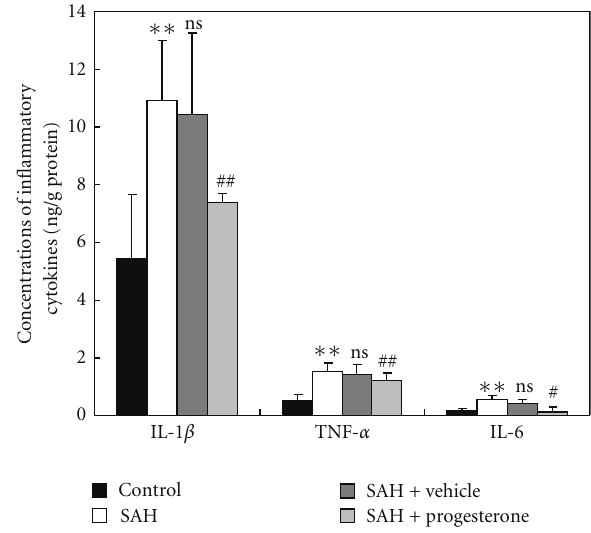
Figure 4: Changes of inflammatory mediators in the injured brains as determined by ELISA in control group ( n = 6), SAH group ( n = 6), SAH + vehicle group ( n = 6), and SAH + progesterone group ( n = 6). SAH could induce the significantly increased concentrations of IL-1 β , TNF- α and IL-6 in the rat brain surrounding the blood clot. In SAH + progesterone group, the cortical concentrations of IL-1 β , TNF- α and IL-6 were markedly down-regulated as compared with that of SAH + vehicle group. Bars represent the mean ± SD ( n = 6, each group). ∗∗ P < . 01 compared with control group, # P < . 05 compared with SAH + vehicle group, ## P < . 01 compared with SAH + vehicle group, ns P > . 05 compared with SAH group.